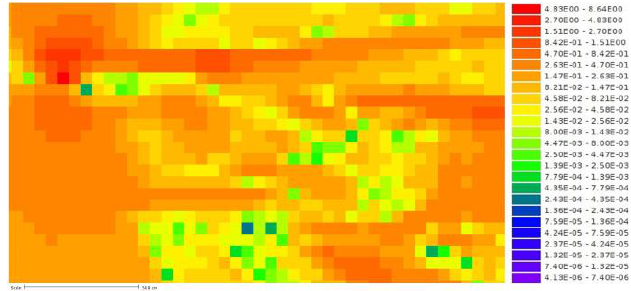
Fig. 8. Total photon flux - MCNP [par.cm -2 .s -1 ]